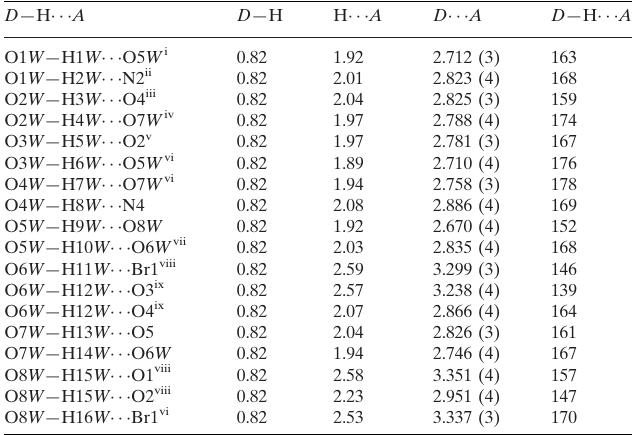
Key indicators: single-crystal X-ray study; T = 295 K; mean (cid:2) (C–C) = 0.005 A˚; R factor = 0.027; wR factor = 0.072; data-to-parameter ratio = 16.6. In the title heterometallic complex, {[Er(C H N O ) ] (cid:2) 4H O} , the Er III atom is eight-coordin- [CuBr(C n 5 3 2 2 2 2 ated by four O atoms from two centrosymmetric oxalate ligands and four water molecules, displaying a bicapped trigonal-prismatic geometry. The oxalate ligands bridge the Er atoms into a polymeric cationic chain along [110]. The Cu II atom is five-coordinated in a square-pyramidal geometry by two pyrazine-2-carboxylate ligands and a Br atom, forming a three-dimensional supramolecular network through O— Related literature